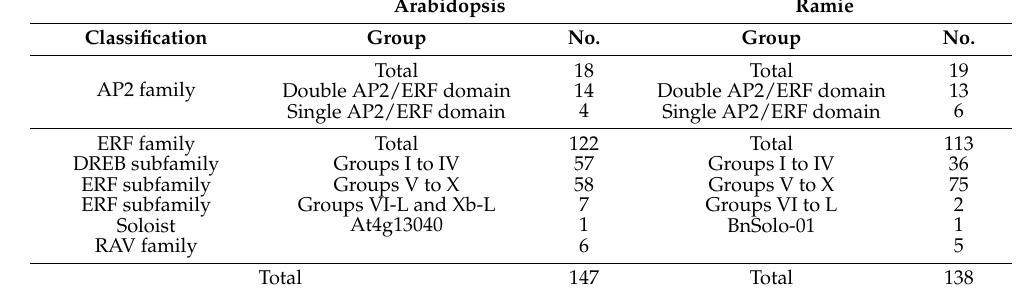
Table 1. The profile and comparison of AP2/ERF superfamily TF genes between ramie and Arabidopsis.